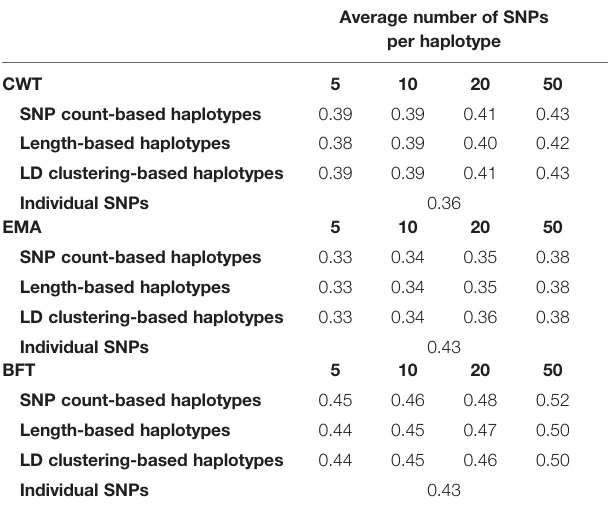
TABLE 4 | Estimated heritabilities using haplotypes de fi ned by different methods and sizes and using individual